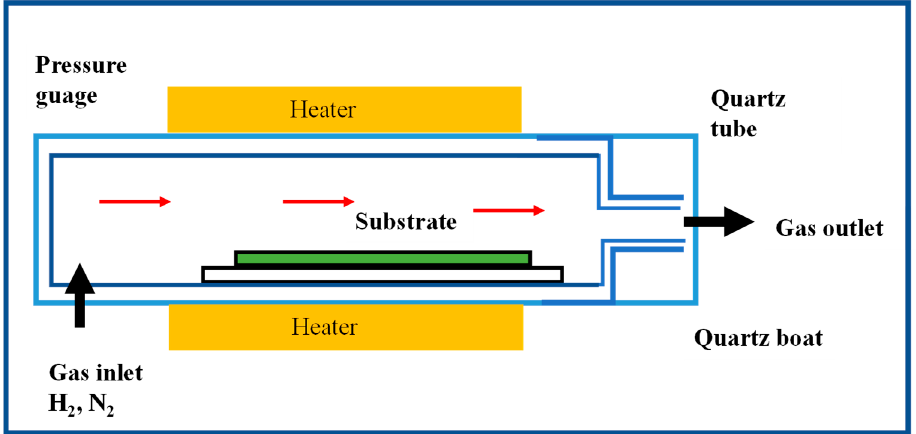
Figure 6. Schematic illustration of a CVD set-up.